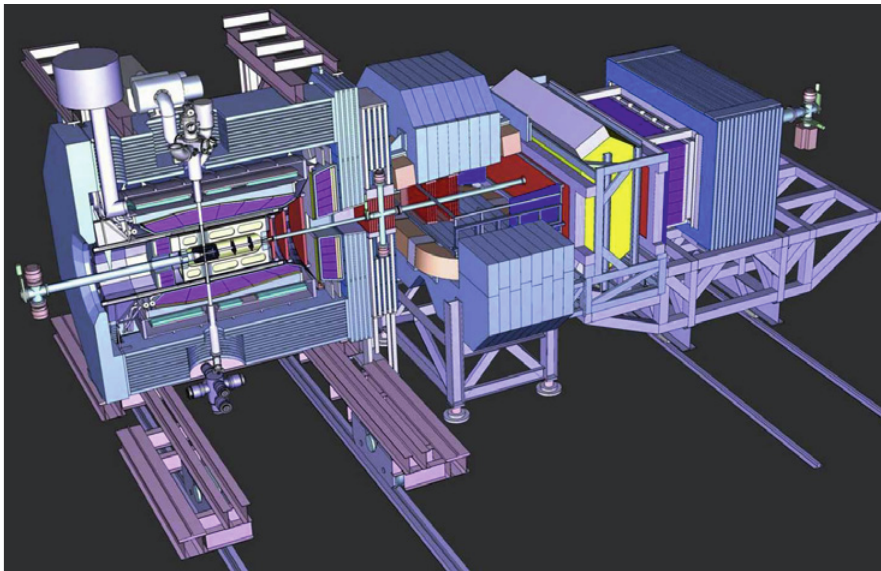
Figure 1. Top view of the PANDA apparatus